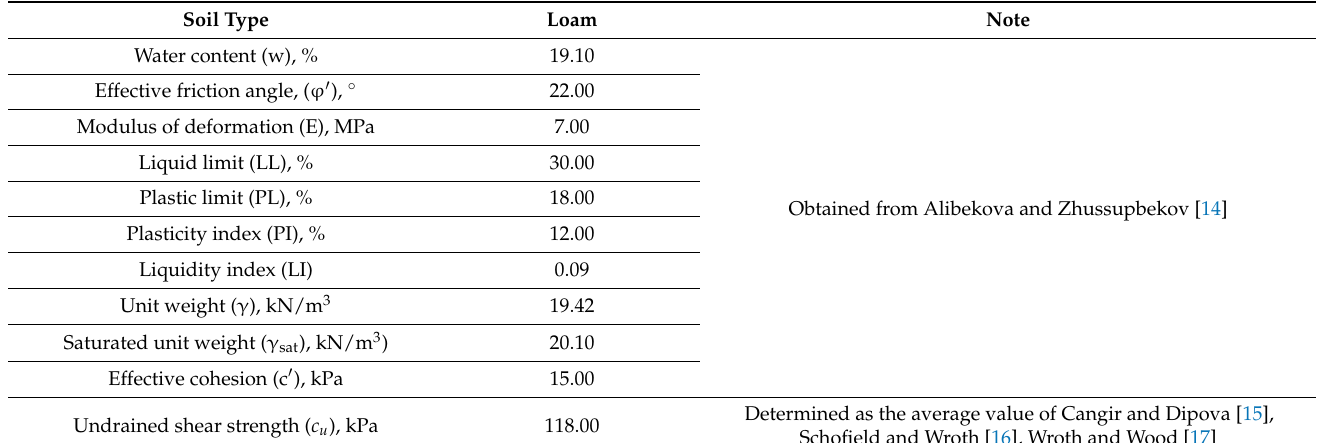
Table 1. Soil engineering properties in Nur-Sultan city.